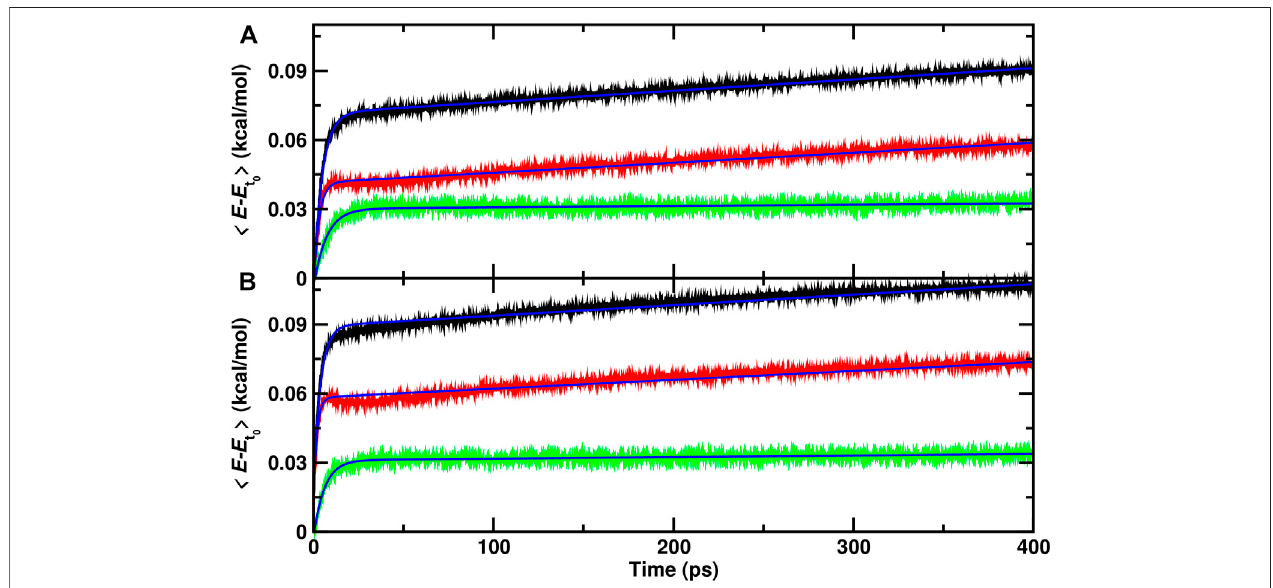
FIGURE 3 | Average total (black), internal (red) and translational (green) energies for water over 70 independent runs relative to the average before recombination. The time of reaction for all trajectories is shifted to t (cid:2) 0 and de fi ned by the fi rst instance at which r C − O recombination for CO A + O B on the top of the ASW surface. The blue solid line is a fi t to an empirical expression ϵ (cid:2) a 0 e − t / a 1 + a 2 t + a 3 , see text.